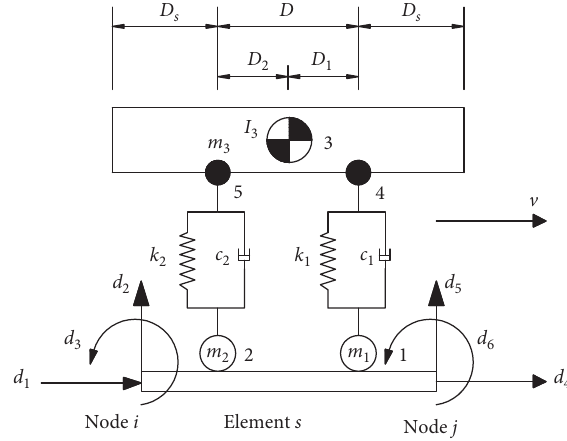
Figure 1: Vehicle-bridge